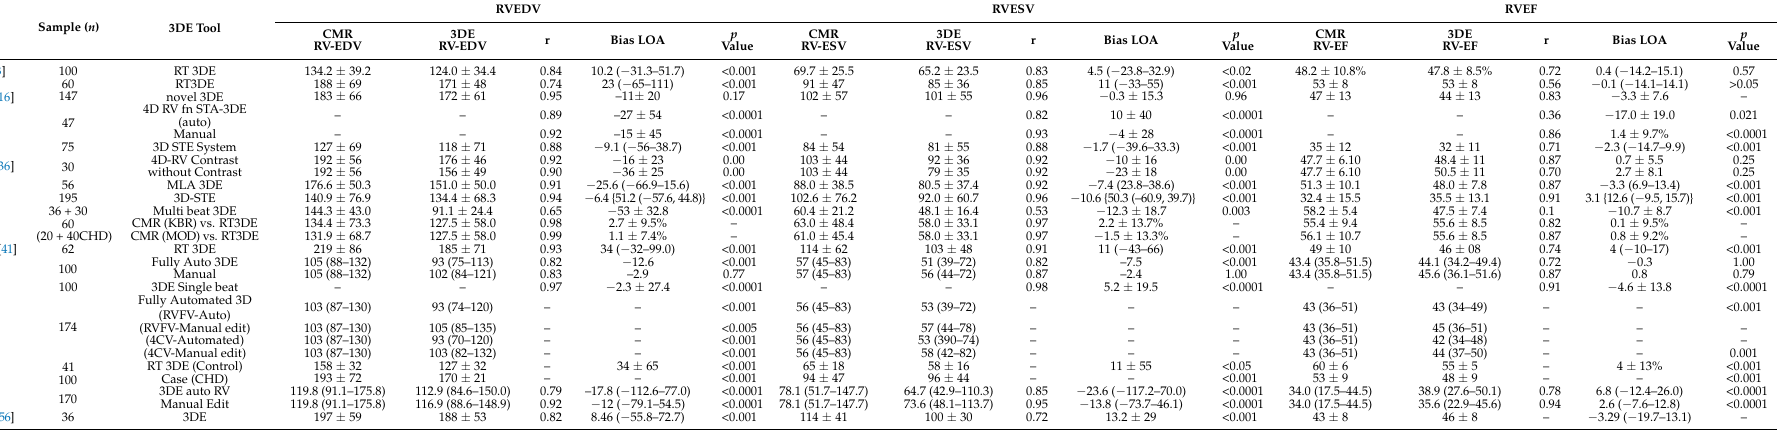
Table 1. Comparison of 3DE RV quantification with cardiac magnetic